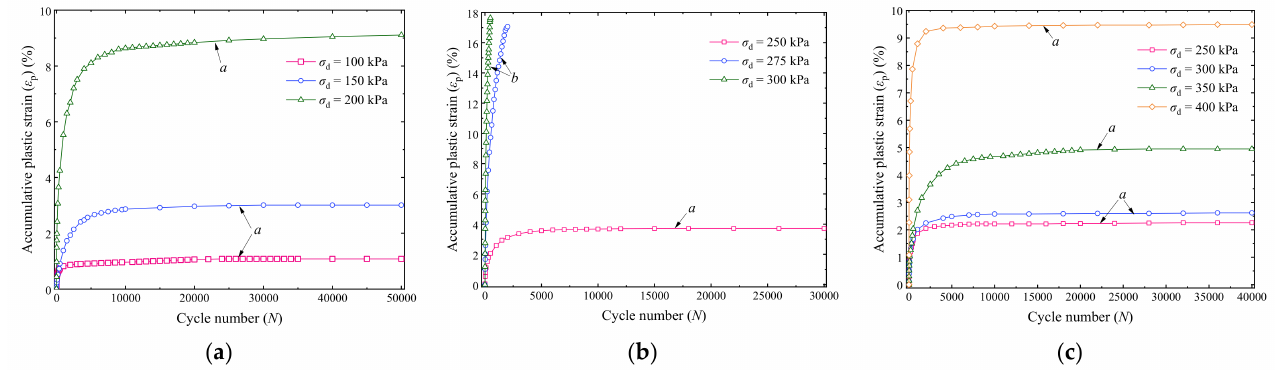
Figure 6. ε p — N relationship of specimens with optimal moisture content: ( a ) σ 3 = 15 kPa; ( b ) σ 3 = 30 kPa; ( c ) σ 3 = 60